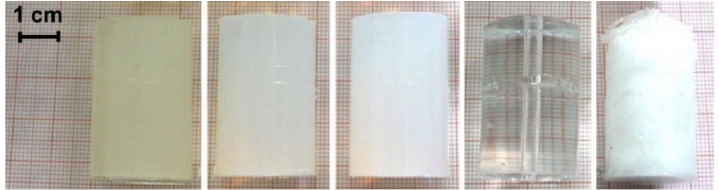
Figure 7. Photographs of freshly prepared native hydrogels of the final gel formulations: 3 wt.% alginate, 2 wt.% agar, 2 wt.% agarose, 10 wt.% PAA and 15 wt.% PVA (from left to right), reproduced with permission from [59].